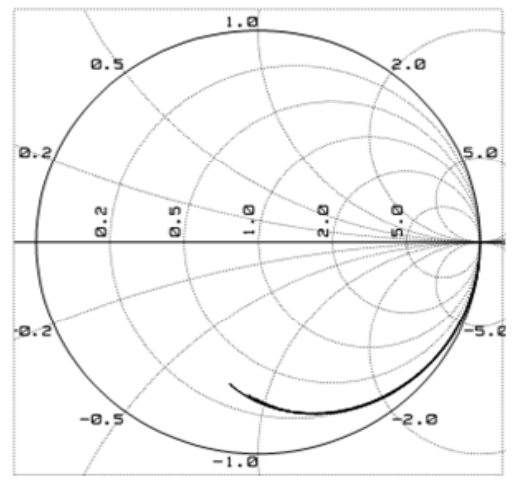
Figure 11. Smith chart for the monolithically integrated photodetector.